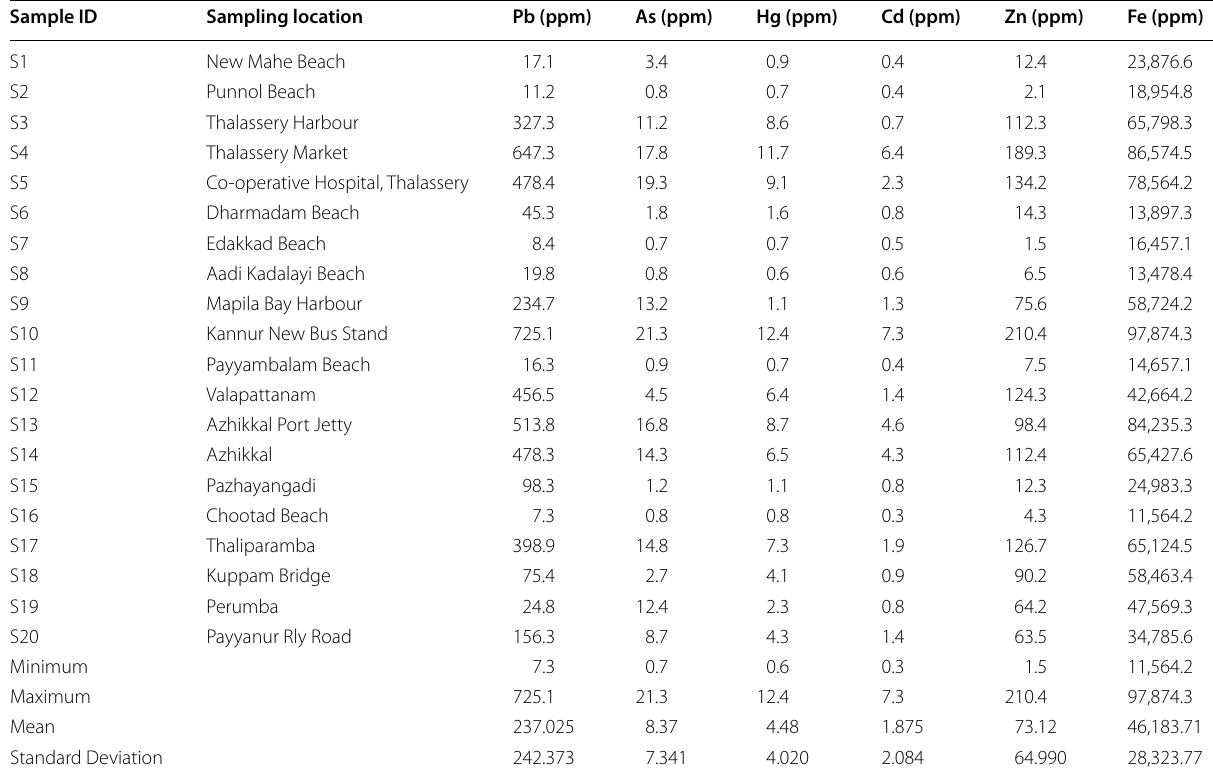
Table 7 Concentration of heavy metals in soil samples of Kannur district Sample